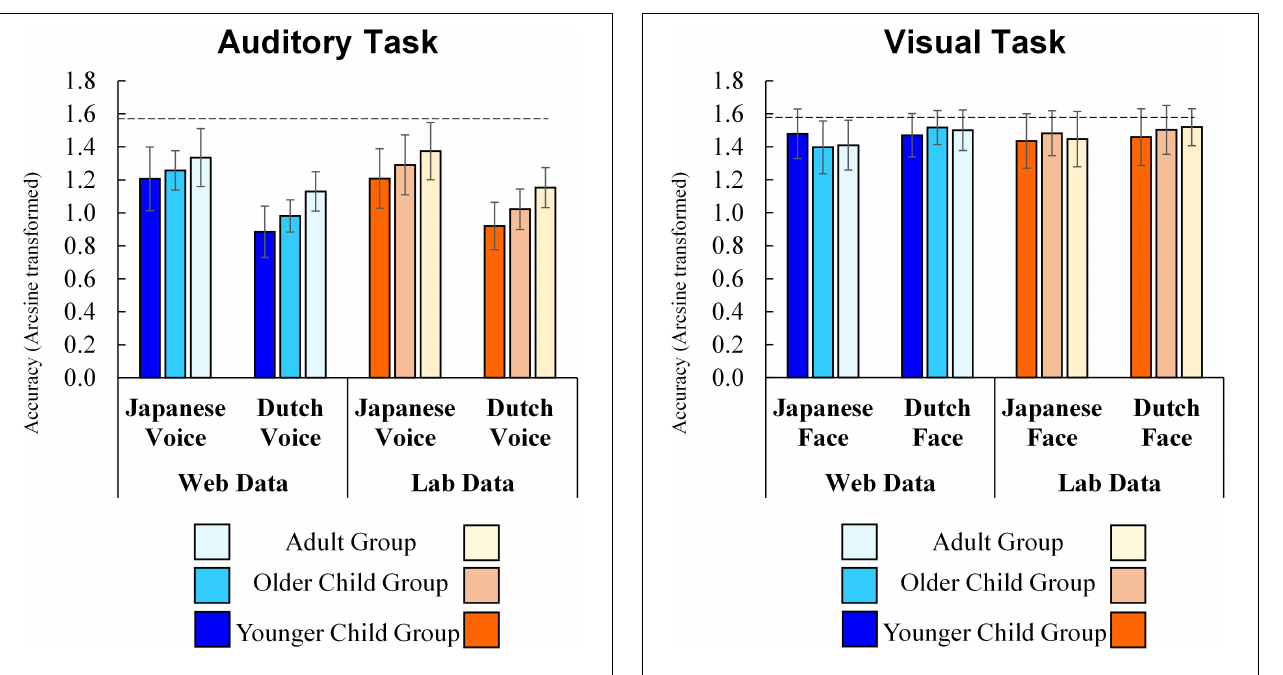
participants responded correctly to the Dutch face more often than to the Japanese face. Interaction between age group and stimulus culture ( F (2, 257) = 3.05, p = 0.049, η p2 = 0.023) was also significant, but the main effect for age group was not (F(2, 257) = 0.19, p = 0.829, η p2 = 0.001). A simple main effect